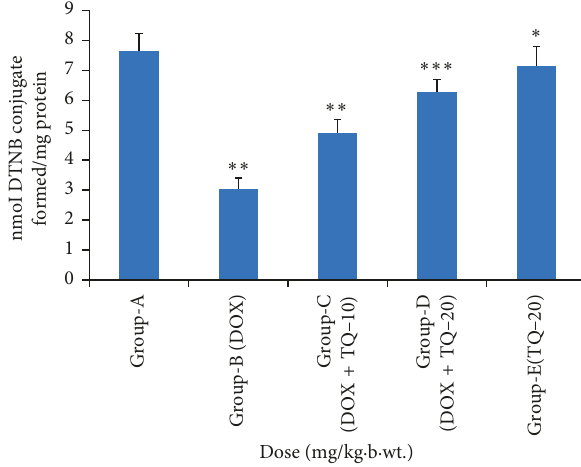
Figure 3: Effect of thymoquinone on glutathione (GSH) in cardiac tissue. ∗∗ significant (Group-E vs